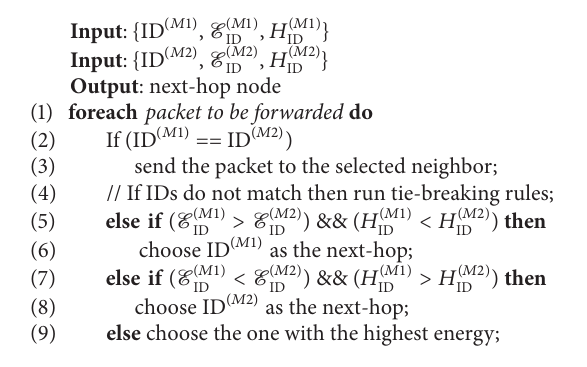
Algorithm 1: The decision maker (DM)